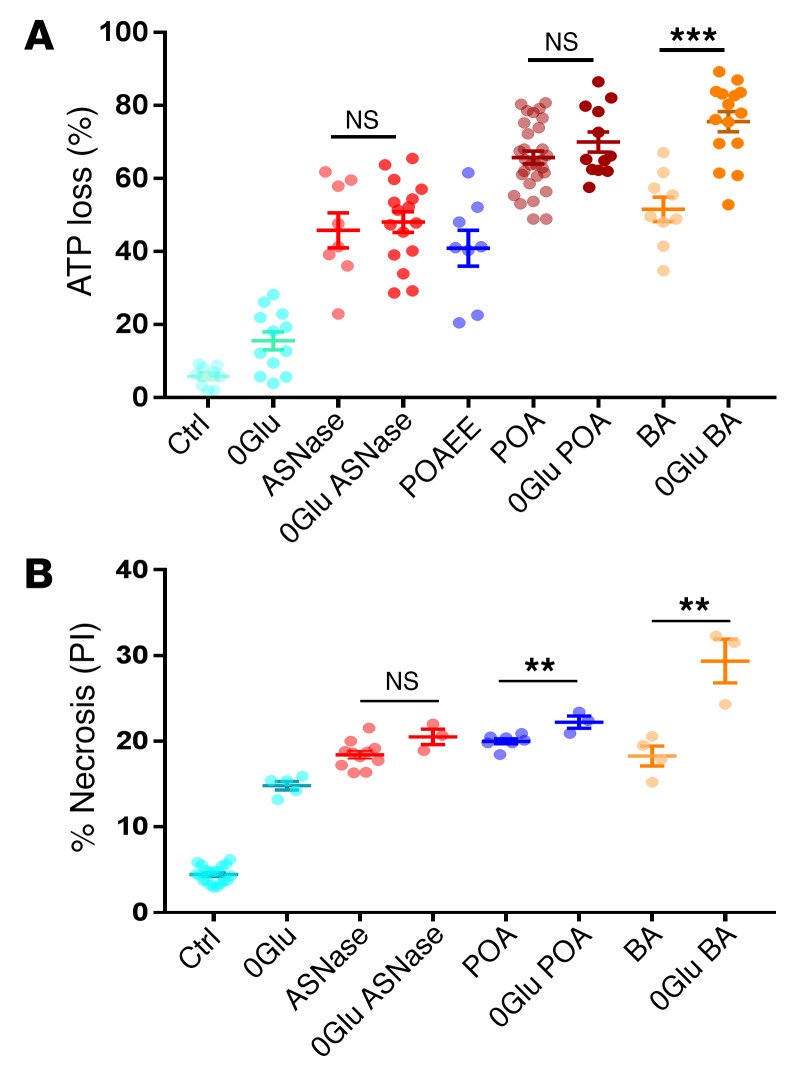
Asparaginase, POAEE with POA, and BAs all induce substantial ATP loss and cell necrosis.(A) Comparison of cellular ATP depletion in PACs after treatment of cells for 30 minutes with or without glucose (0Glu), or application of asparaginase (ASNase), POAEE, POA, or BA. Level of ATP loss (measured by MgGreen) is shown as a percentage of full depletion by a mixture of CCCP, oligomycin, and iodoacetate. Dots represent ATP loss (%) in each cell. Data are shown as mean ± SEM. Ctrl, control. (B) Summary of cell necrosis measurements in PACs treated with asparaginase, POA, or BA for 2 hours in the presence or absence of 10 mM glucose as compared with control. Removal of glucose had little effect on asparaginase and POA, but increased BA-induced necrosis. Cells were stained with PI. Dots represent series of experiments with n > 100 cells in each sample. Data are shown as mean ± SEM. **P < 0.01; ***P < 0.001, 1-way ANOVA.